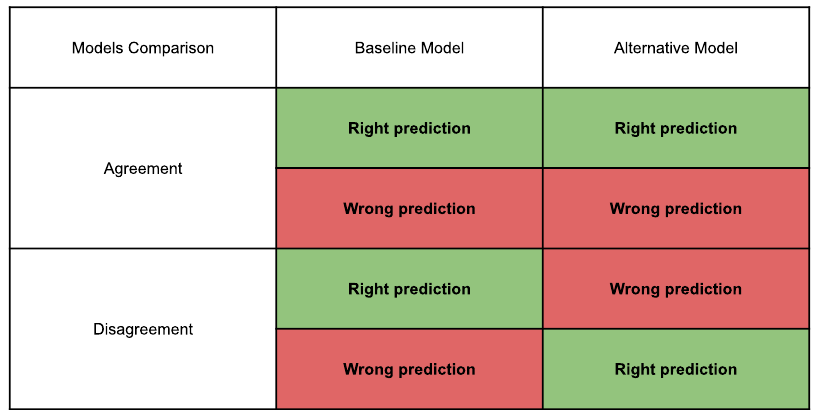
Figure 20. Quadrant analysis layout. Two classifiers, a baseline model and an alternative one, repre- sented here by the red and blue boxes, respectively, are compared to each other in the four possible situations: both in agreement (either right or wrong in the classification task) or in disagreement (either baseline or alternative right).